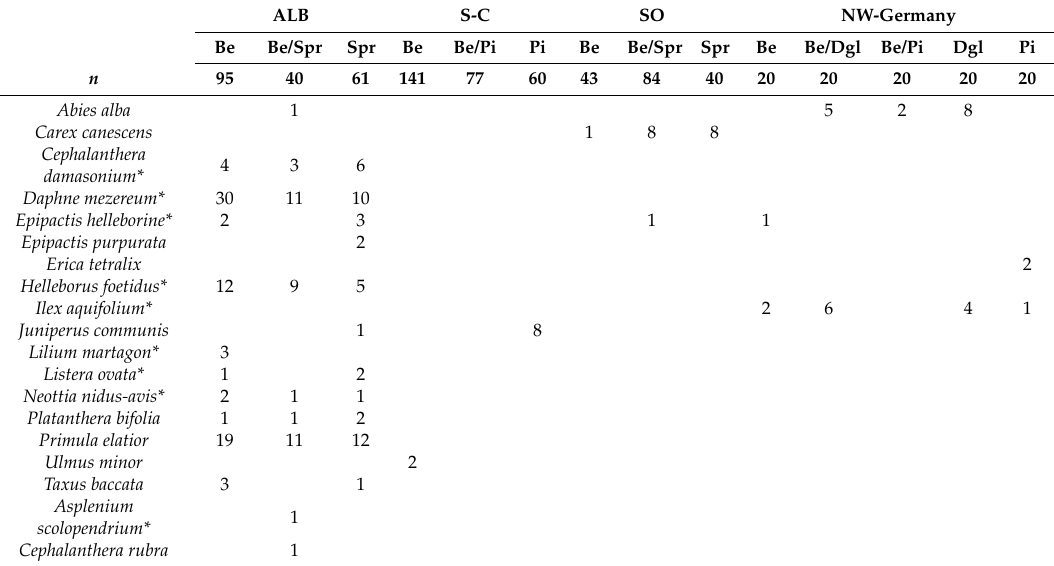
Table A2. Number of occurrences of threatened and protected vascular plant species in the survey plots ( n = total number of plots) of pure and mixed stands in the Schwäbische Alb (ALB), Schorfheide-Chorin (S-C), Solling (SO) and NW-Germany. Be = pure beech stands, Spr = pure spruce stands, Pi = pure pine stands, Be/Spr = beech/spruce mixture, Be/Pi = beech/pine mixture, Be/Dgl = beech/Douglas fir mixture. Species with single occurrences are listed at the end of the table. * marks species not listed in the red list of vascular plants of Germany but protected by